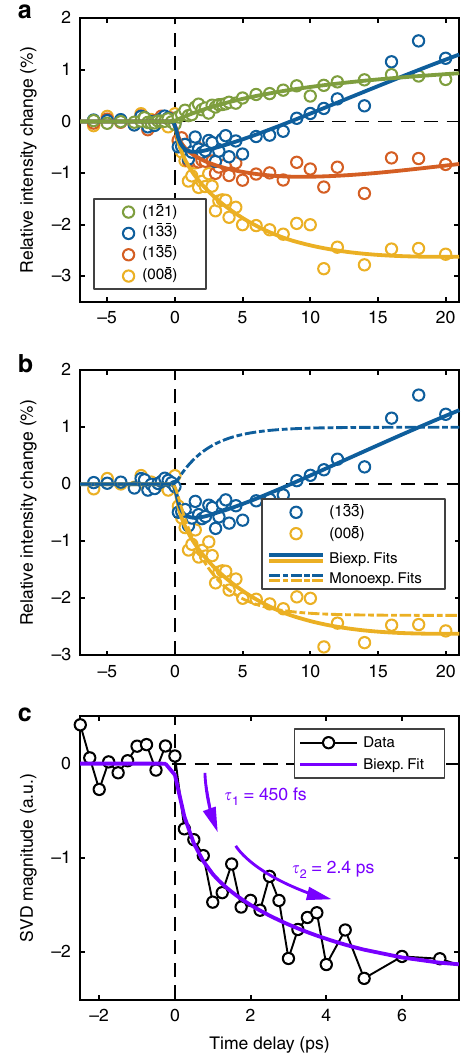
Fig. 3 Photoinduced evolution of Bragg spots intensity. a Short-time relative change in the intensity of select Bragg spots from t = − 7 to 20ps. b Global fi tting of Bragg spots to show biexponential fi t and monoexponential fi t of relative intensity changes. c These intensity changes of the Bragg peaks are best modeled as a biexponential, with a (450±23)-fs fast component and a (2.4±0.4)-ps slow component. The solid lines represent the global fi tting of the evolution of the intensity of the selected Bragg spots.